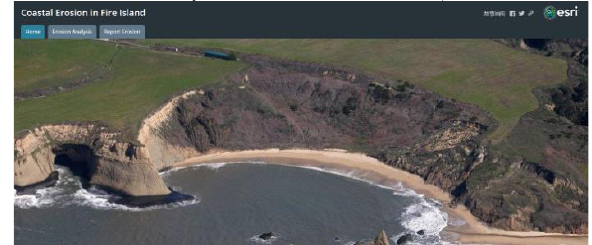
Figure 9. Website initial page (Note: Screen shot from website)